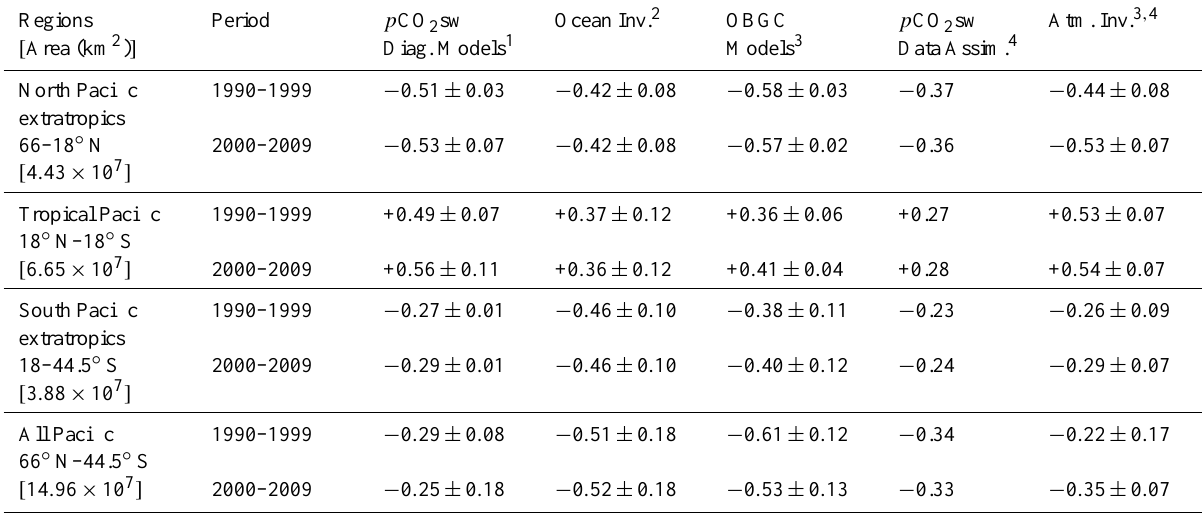
Table A1. Decadal mean values of the regionally integrated air–sea CO 2 flux in three sub-basins of the Pacific Ocean evaluated from various approaches. All units arePgCyr − 1 .